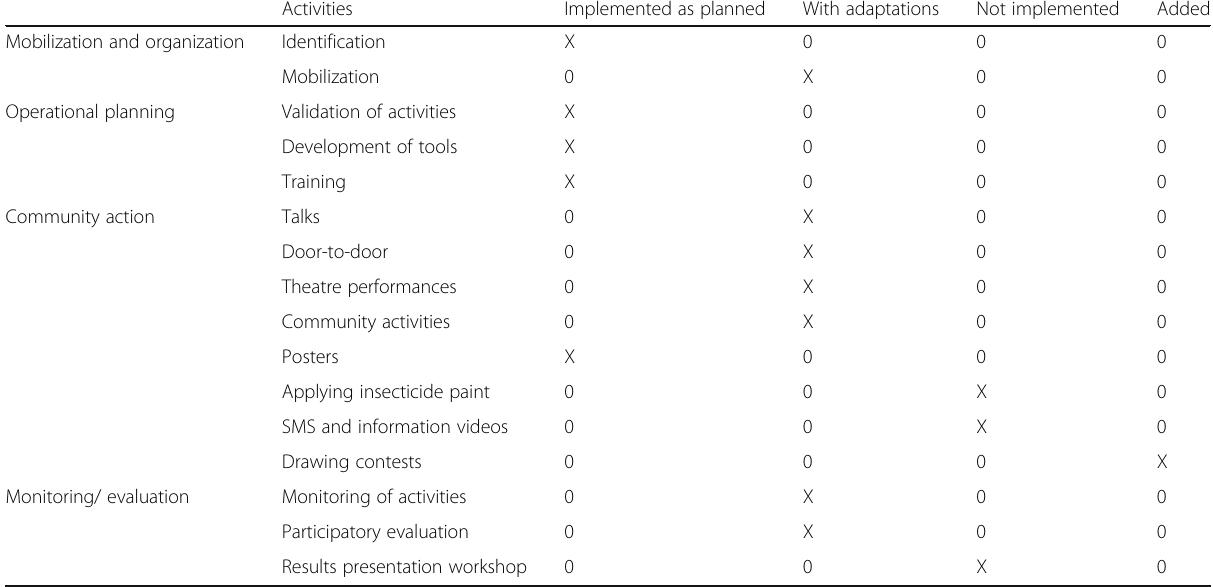
Table 3 Fidelity grid for the community intervention against dengue in Ouagadougou